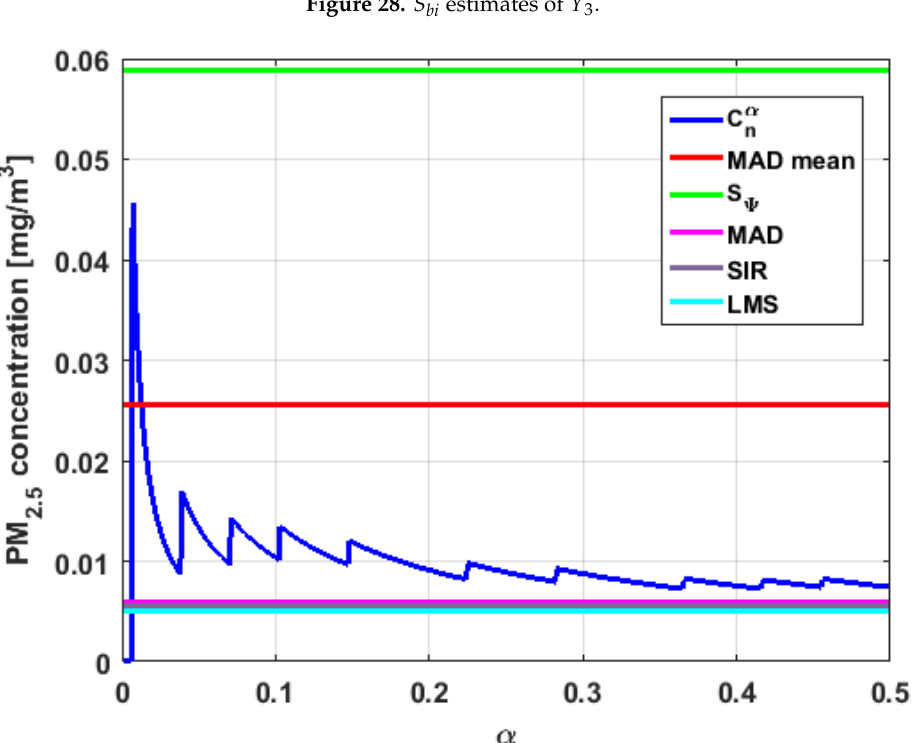
Figure 29. 𝐶 𝑛𝛼 estimates of 𝑋 1 .